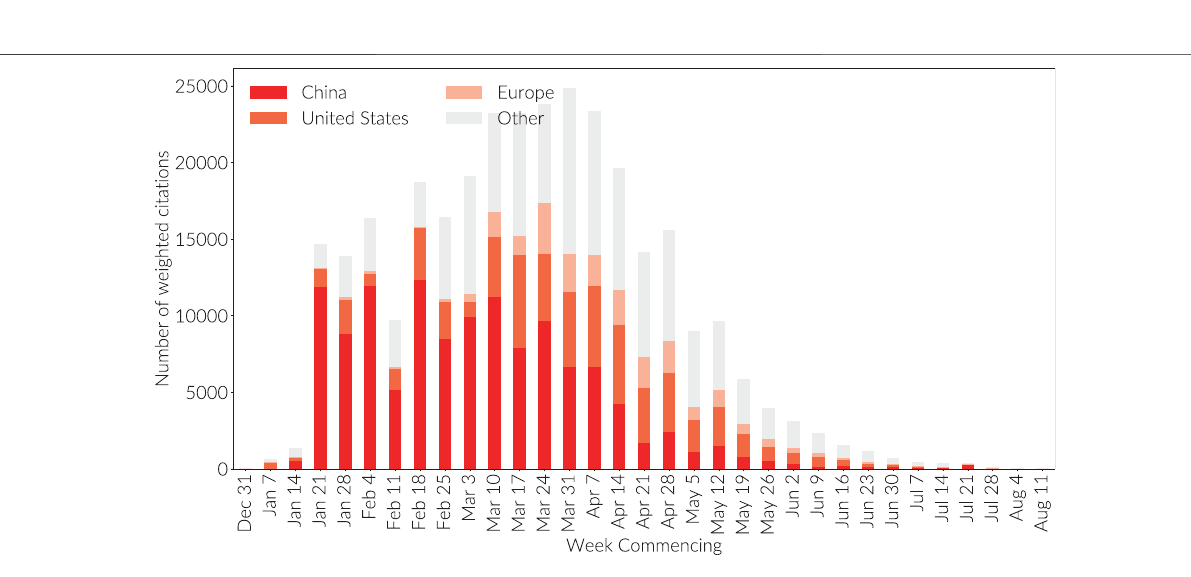
FIGURE 7 | Fractional citations to all COVID publications by receiving country determined by researcher af fi liation. Totals by week in which citations were made. COVID research is de fi ned relative to the boxed query in this report. Only citations from other COVID papers have been considered. All numbers are derived from Dimensions on May 24,